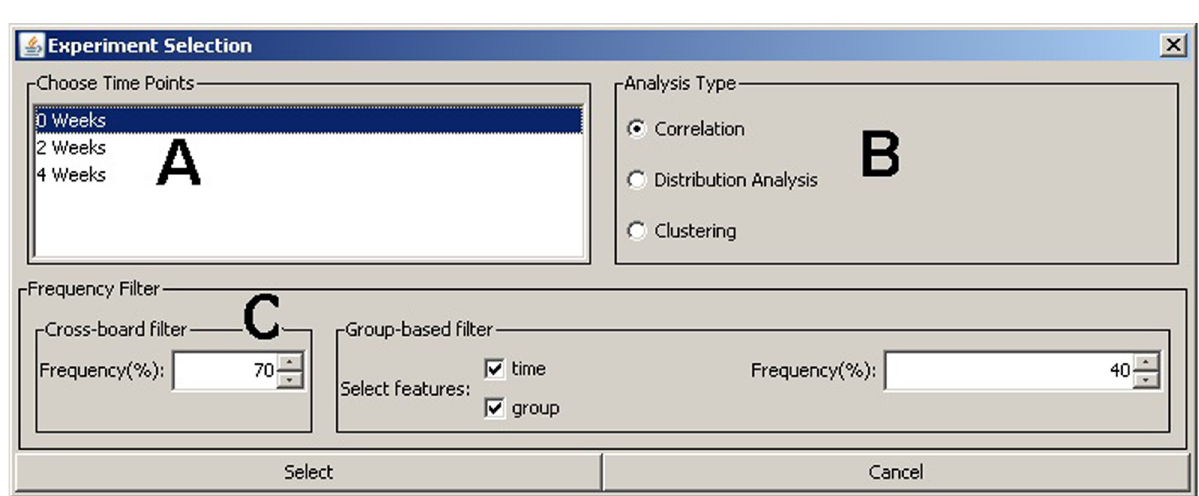
Fig 1. Experiment selection window. (A) Time points available for this experiment (in our case study we chose all three time points). (B) Analysis type to perform. (C) Molecules (peaks) frequency filter across all samples (cross-board filter) and also per group of selected features (group-based